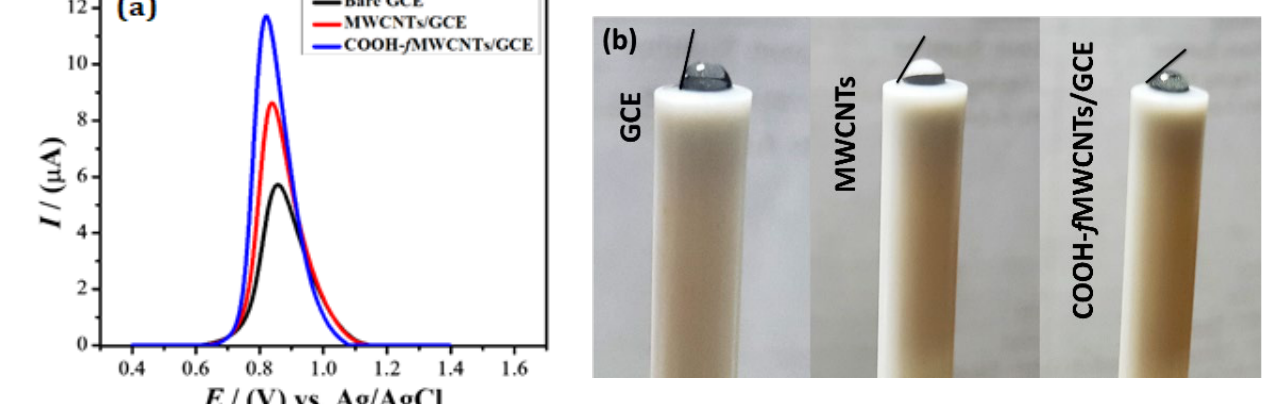
Figure 2. ( a ) SWVs response of 10 μM NBS at bare GCE, MWCNTS/GCE, and COOH- f MWCNTs/GCE in PBS of pH 6.0. ( b ) Picture recorded after 30 s placement of the same volume of water droplet on bare GCE, MWCNTs/GCE and COOH- f MWCNTs/GCE. on bare GCE, MWCNTs/GCE and COOH- f